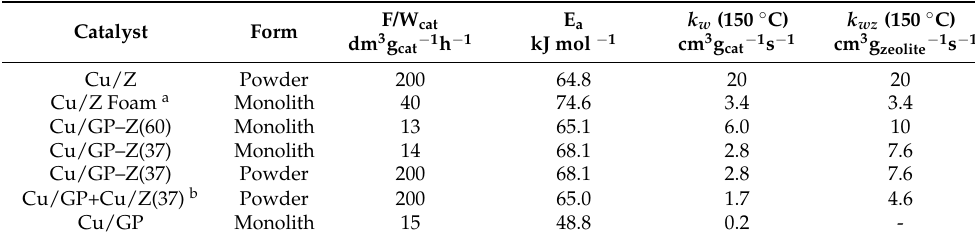
Table 3. Apparent activation energy (E a ) and first-order kinetic constant values at 150 ◦ C ( k w , k wz : per unit mass of catalyst or zeolite fraction, respectively) for the NO removal rate by NH 3 -SCR on composite Cu/GP–Z(x) and reference catalysts calculated from conversion data collected under the specified experimental